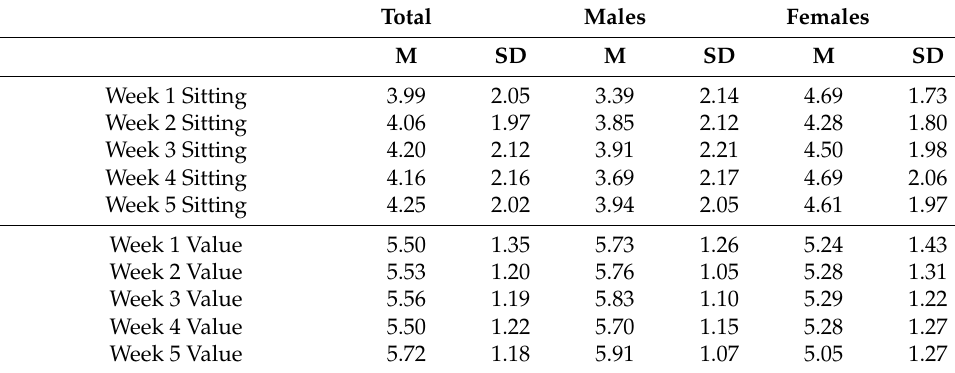
Table 1. Descriptive statistics of prolonged sitting and physical activity value.